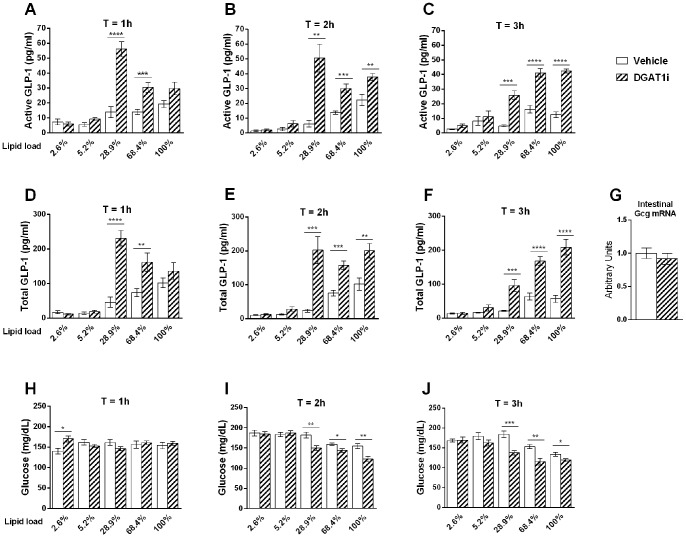
Effects of DGAT1 inhibition on postprandial GLP-1.3-month-old lean C57BL/6N mice were p.o. dosed with DGAT1i at 3 mg/kg body weight and fasted overnight. The next morning, mice were p.o. dosed with mixed meals containing 2.6 (water:Ensure-plus = 1:1), 5.2, 28.9, 68.4, or 100% (corn oil:Ensure-plus = 0∶1, 1∶3, 2∶1, 1∶0 v/v) lipid load at 10 ml/kg body weight (0.74, 1.48, 3.15, 5.92, or 8.14 kcal/ml). At 1, 2, or 3h after meal challenge, plasma levels of (A–C) active GLP-1, (D–F) total GLP-1, and (H–J) blood glucose were measured. (G) 3-month-old lean C57BL/6N mice were p.o. dosed with 3 mg/kg DGAT1i or vehicle and fasted overnight. 18h after dosing, jejunal mucosa was harvested, and Gcg mRNA expression was measured by realtime PCR. Data are normalized against β-actin mRNA. N = 8. *P<0.05, **P<0.01, ***P<0.001, ****P<0.0001 between groups.